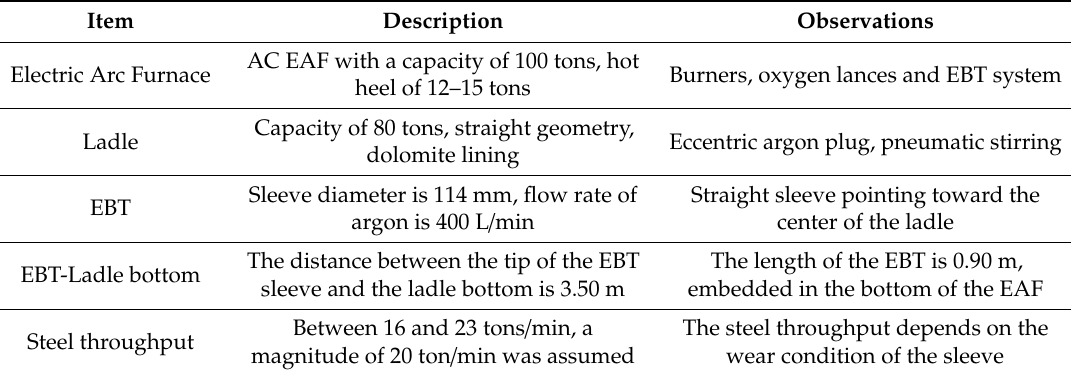
Table 2. Tapping conditions of liquid steel from furnace to